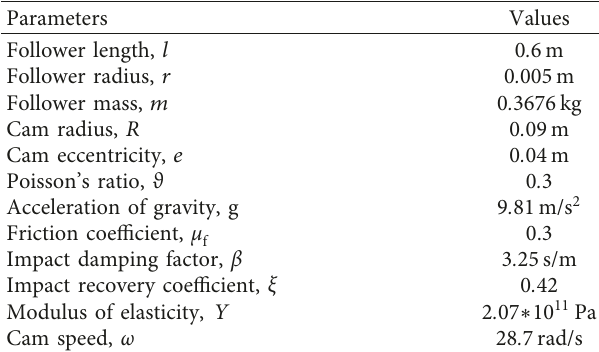
Table 1: Values of the system